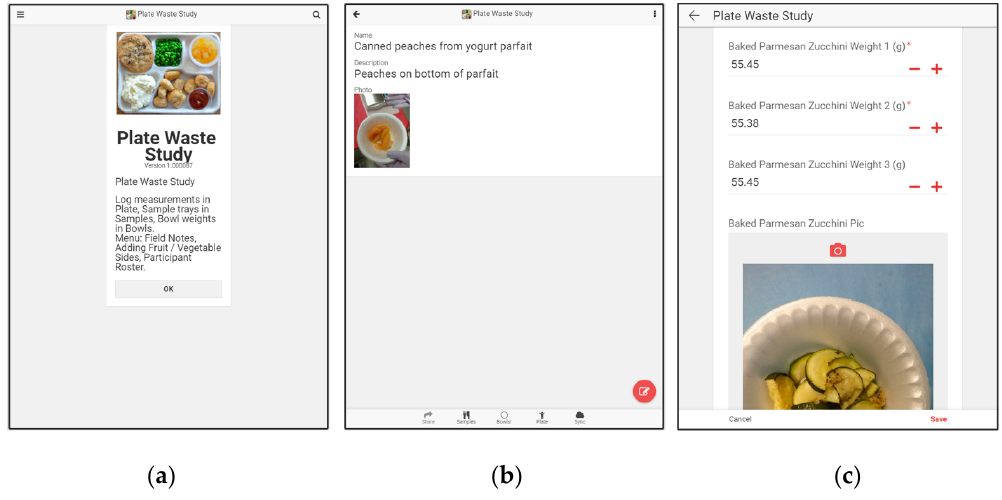
Figure 1. App Screenshots. These screenshots depict the user experience within the app. Initial welcome screen with brief reminder of menus ( a ), a sample fruit and vegetable (F&V) item entry including a name, description, and photograph of the sample ( b ), as well as a lunch tray measurement entry ( c ) which includes a record of the data collector entering item weights and a photo. Additionally, each tray record includes all F&V items selected by the student, an item status (entirely consumed or not eaten) if not weighed, as well as relevant notes.